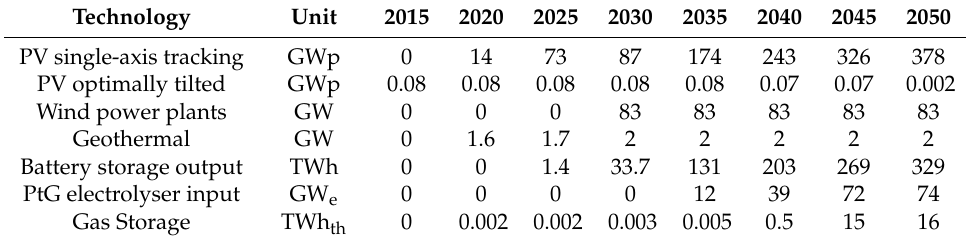
Table A4. Key power capacities required for the energy transition pathway for KSA from 2015 to